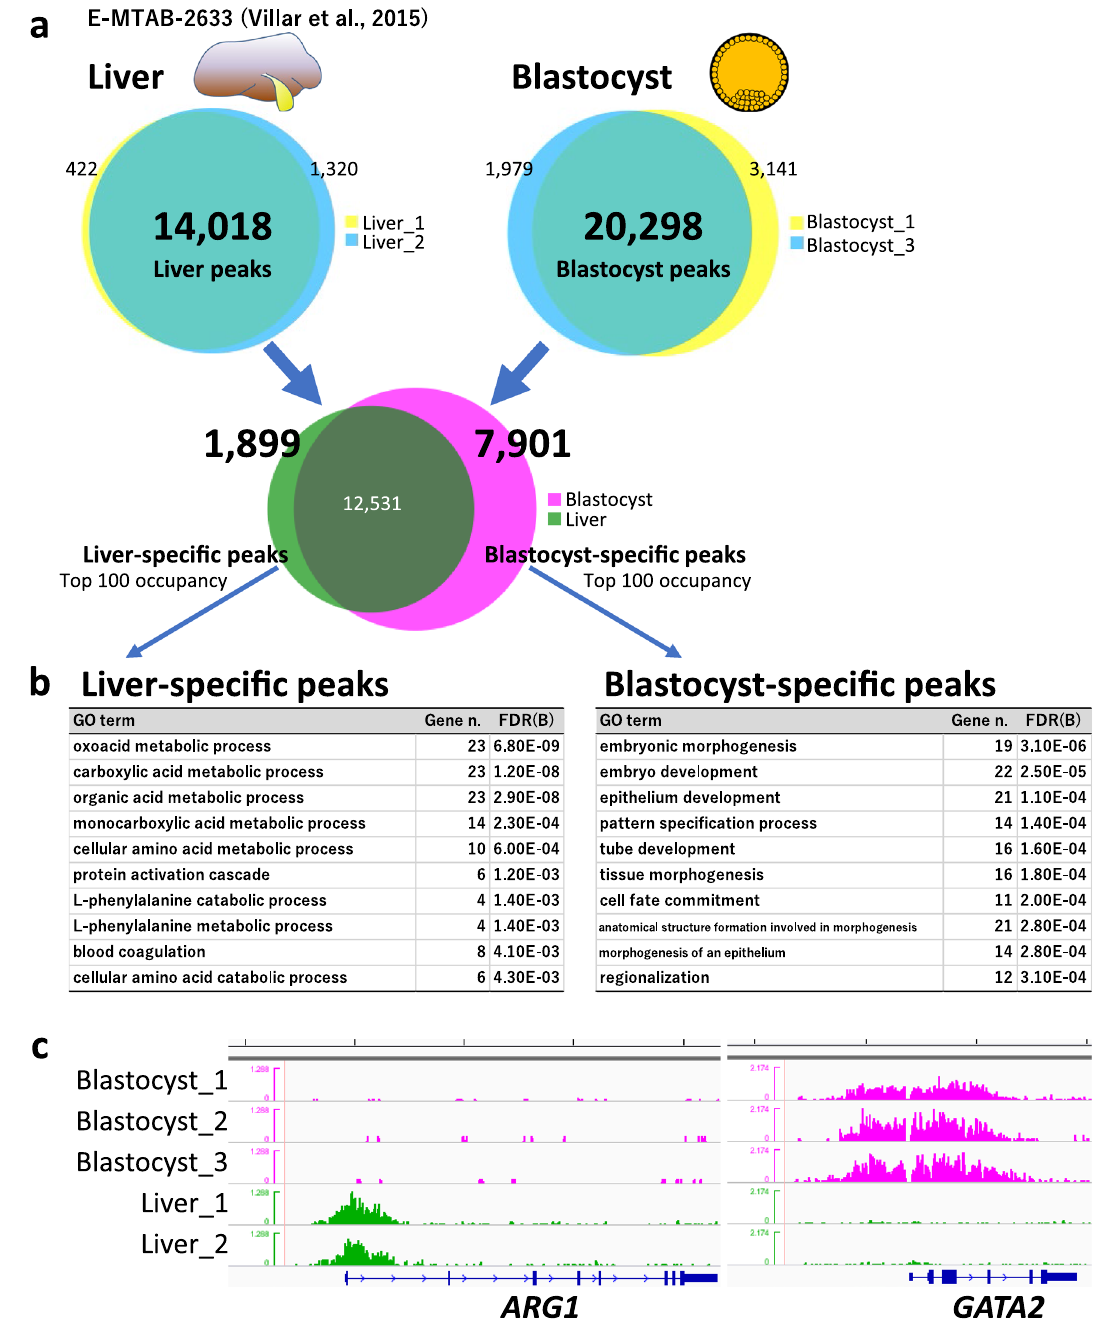
Figure 2. Characterization of blastocyst- and liver-specific H3K4me3 modifications. ( a ) Processing of ChIP- peaks in liver and blastocyst samples. The numbers show those of the peaks. The sum of common (intersect) and specific peak numbers is not equal to the original peak number in each sample because some peaks were separated into multiple peaks to represent intersects. ( b ) Top 10 significant GO terms for biological process enriched by the genes with the top 100 highest peak occupancy rates. Gene n. represents the numbers of related genes. FDR(B) indicates the Benjamin false discovery rate. ( c ) Examples of the H3K4me3 landscape of liver- ( ARG1 ) and blastocyst-specific ( GATA2 ) peaks around their TSSs. Five-kb graduations are shown in the top